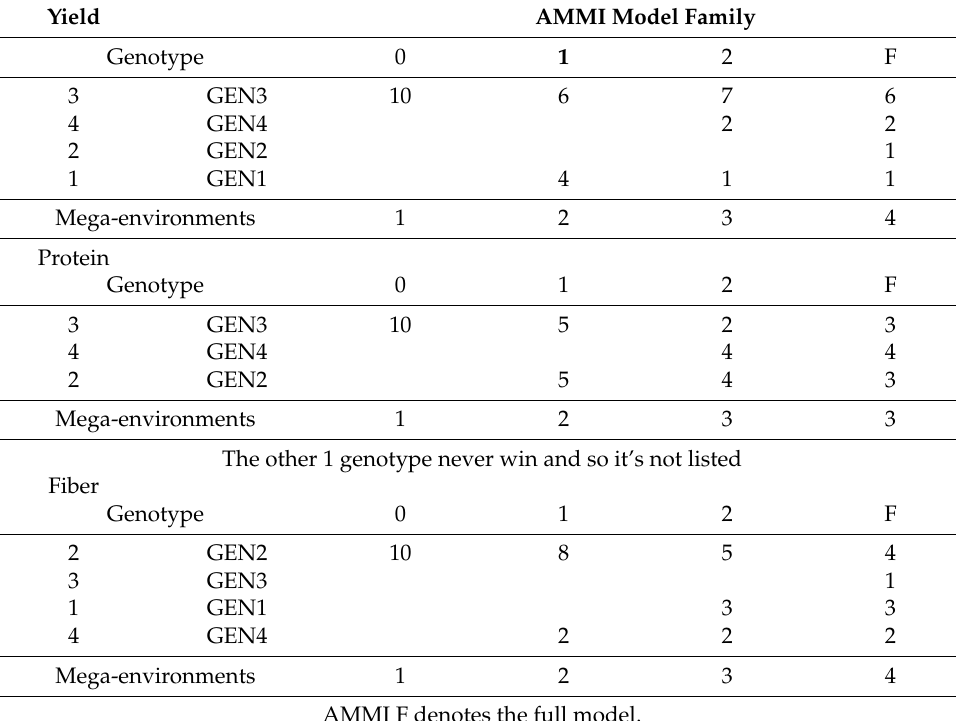
Table 2. AMMI family models for the grain yield, protein content and fiber content dataset, winning genotypes and the numbers of mega-environments.